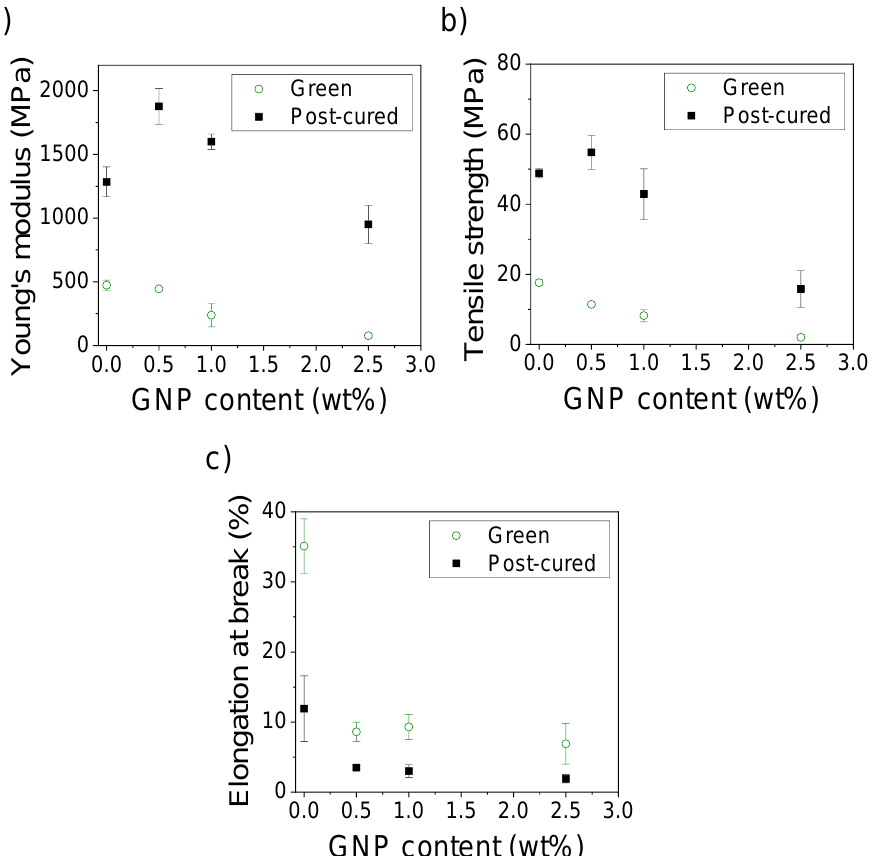
Figure 7. Average ( a ) Young’s modulus; ( b ) tensile strength and ( c ) elongation at break for the green Figure 7. Average a ) Young’s modulus; b ) tensile strength and c ) elongation at break for the green and post-cured nanocomposites containing 0–2.5 wt % and post-cured nanocomposites containing 0–2.5 wt % GNP.